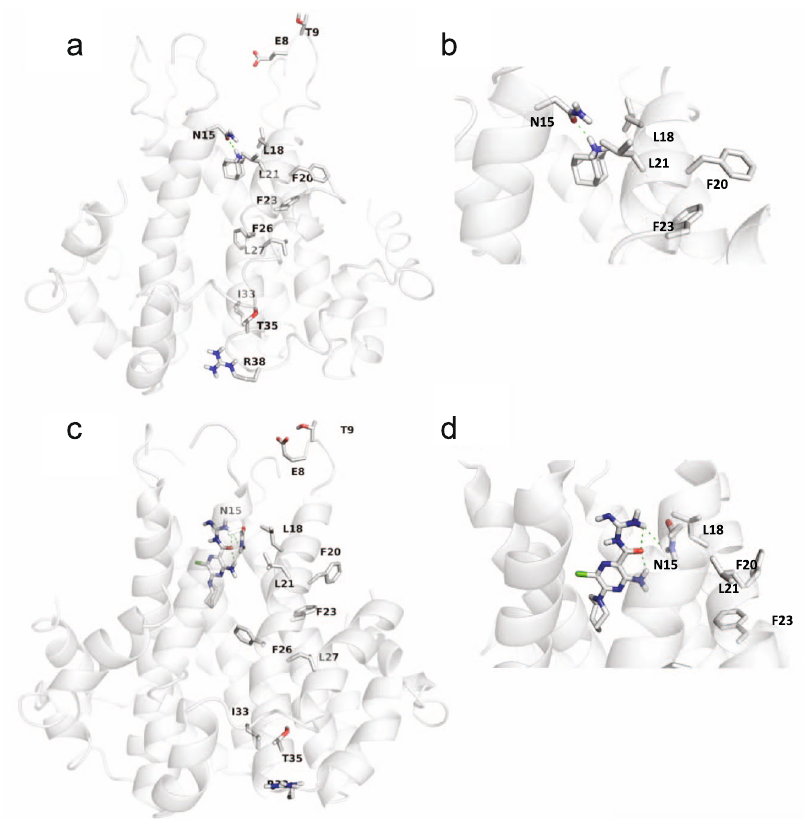
Fig. 3 MD simulations models of Protein E (aa 8 – 65) in complex with amantadine and HMA. a Complex with amantadine, with inset in ( b ) zooming in at the binding site. c Complex with HMA, with inset in ( d ) zooming in at the binding site. The models depict an outward orientation of the drugs with Protein E in an open state (ligand carbons and Protein E in gray) from restrained 100 ns-MD simulations with OPLS2005 force fi eld and a force constant of 2 kcal mol Å − 2 to the Ca atoms of Protein Ε . Ligand and amino – acid residues (shown in only one of the fi ve α -helices for clarity) are shown as sticks. The PDB ID 5X29 16 was used as starting structure (aa 8 – 65) for the Protein E-amantadine